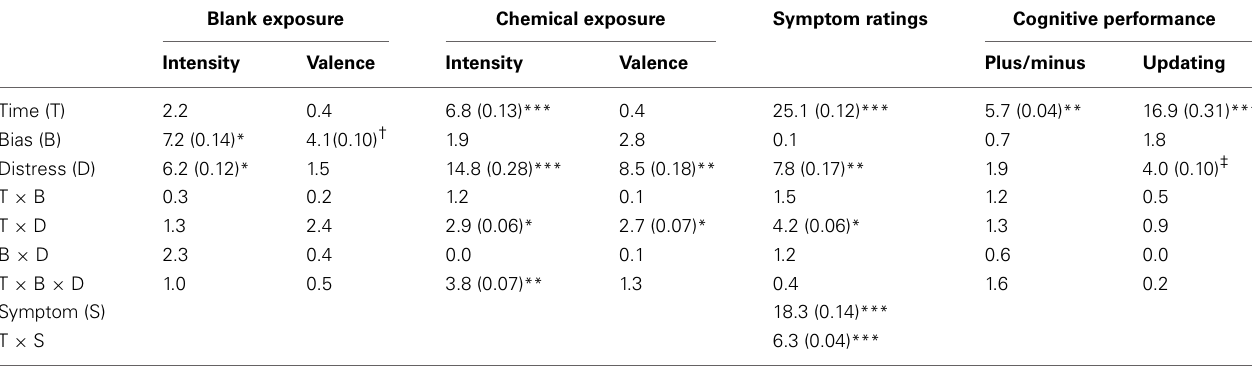
Table 2 | F -values (and, if statistically significant, eta-squared, η 2 ) for the full factorial mixed model